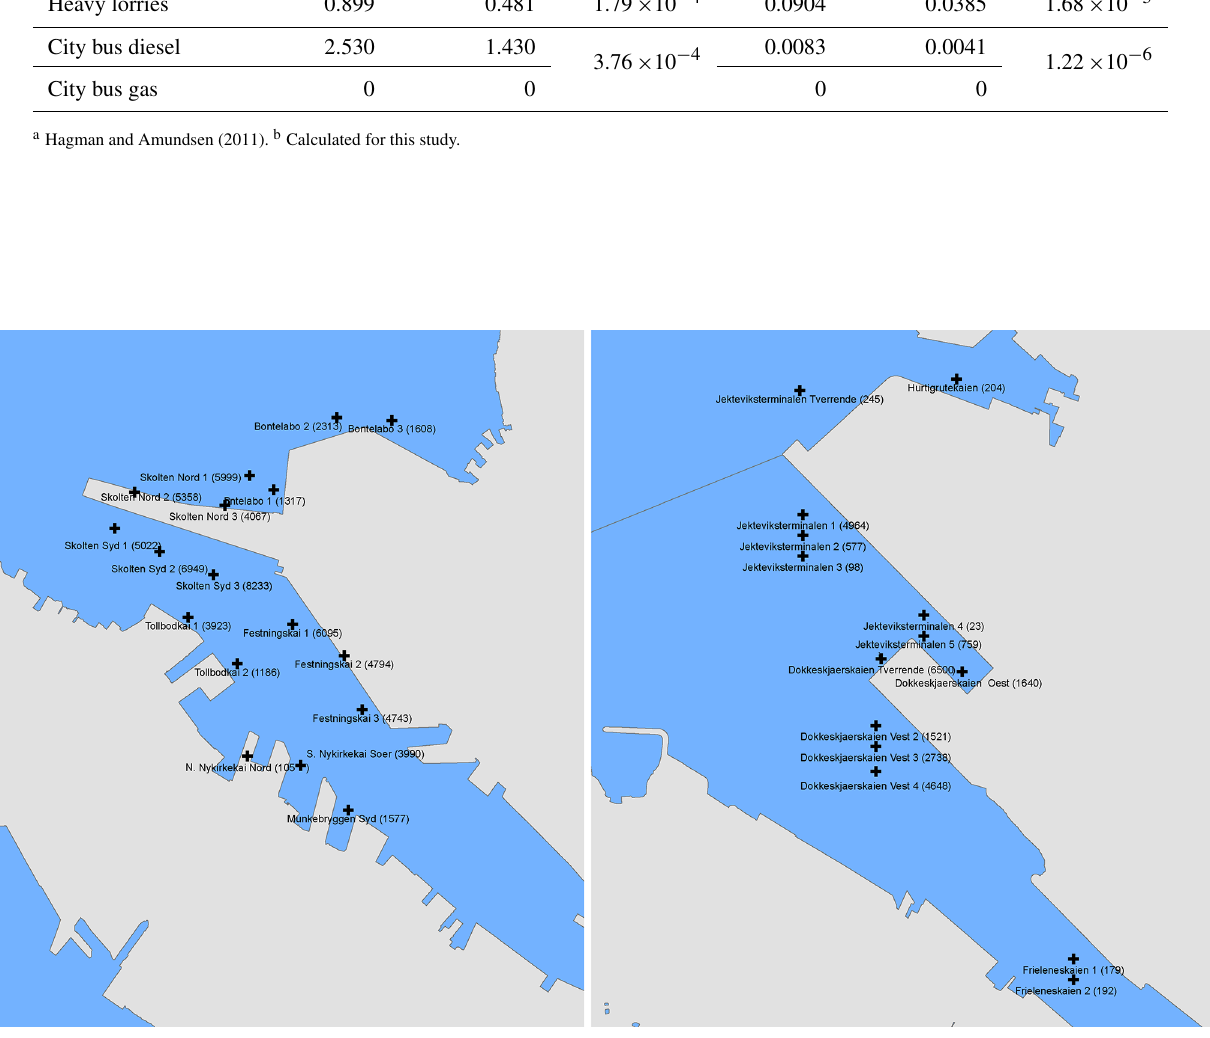
Figure A3. Ship positions in Bergen harbour. The numbers behind the names of the harbour docks indicate the number of hours with supply ships docked at each of the harbour docks from January 2015 to March